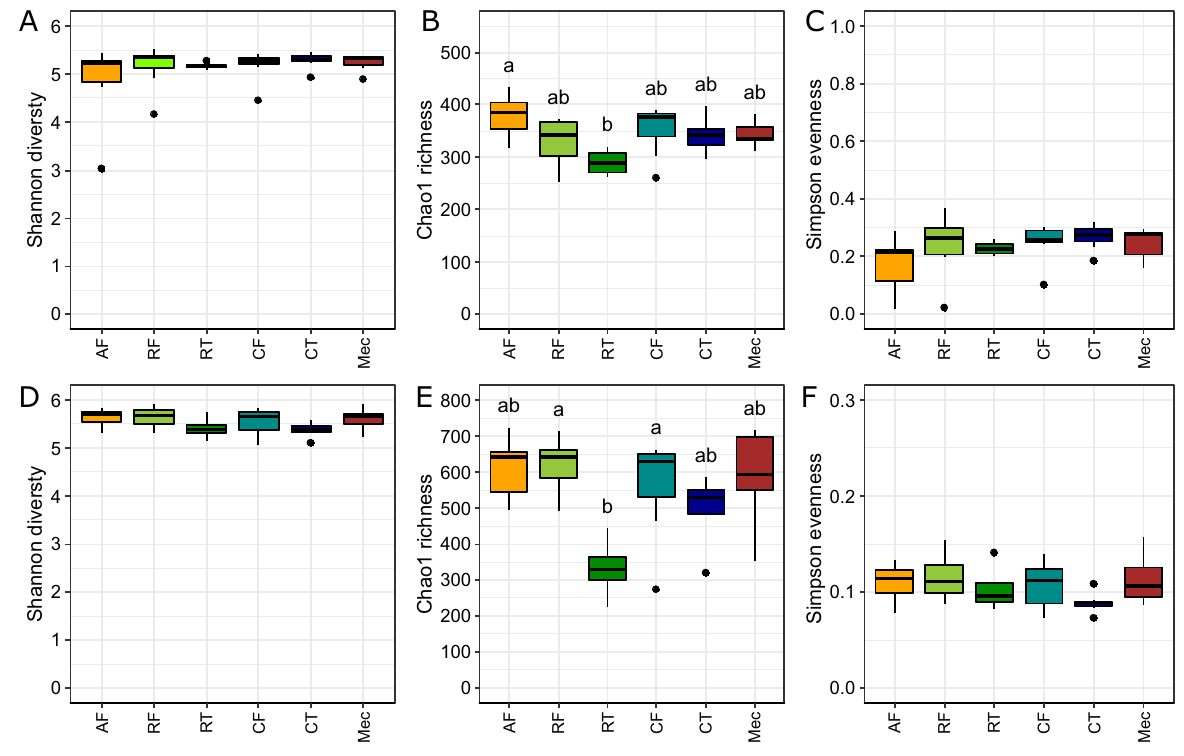
Figure 2. Box plots of bacteria ( A – C ) and archaea ( D – F ) for Shannon diversity indices ( A , D ), observed Chao1 estimates of ESV richness ( B , E ), and Simpson evenness ( C , F ) for communities between GIT components and amniotic fluid. Amniotic fluid (AF), ruminal fluid (RF), ruminal tissue (RT), caecal fluid (CF), caecal tissue (CT), meconium (Mec). Different letters above bars indicate a significant difference via Kruskal–Wallis testing (p <